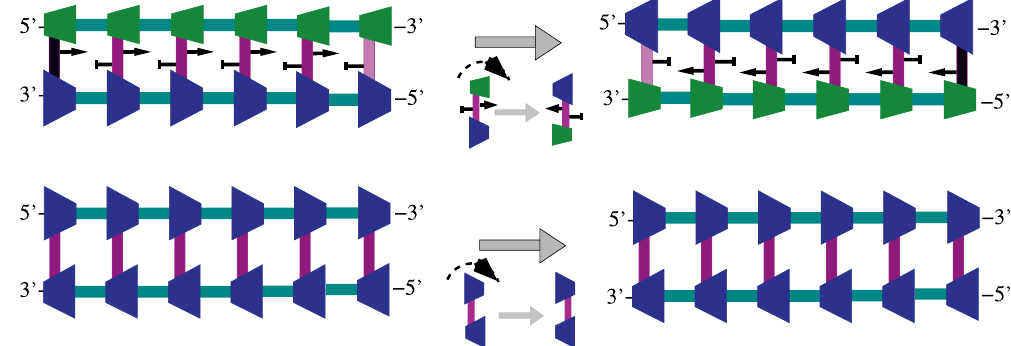
Figure 4. Illustration of the importance of heteromolecular base-pairing or base-pairing between different types of nucleotides. Incorporation of sequence-dependent asymmetric cooperativity requires the base-pair in anti-parallel DNA strands to be left-right asymmetric. On the top left and top right strands, base-pairs between different types of nucleotides, colored green and blue, are left-right asymmetric. Rotating the base-pair results in a directional structure with the blue and green nucleotides exchanged between the two strands, as shown below the arrow in the top center. Thus heteromolecular base-pairs can differentiate between their left and right, are directional, and hence can instantiate asymmetric cooperativity. Rotating the base-pair results in flipping of catalytic and inhibitory arrows associated with the base-pair and thus will impact the unzipping kinetics of the strand. It is easier to unzip the top-left strand from its right end, whereas, for the top-right strand, unzipping from its left end is kinetically favorable. This favorability is illustrated with the color of the hydrogen bonds, which represent the height of the kinetic barrier separating bonded and unbonded configurations, higher the barrier, darker the color. On the other hand, as the bottom left and bottom right strands illustrate, if the two nucleotides of a base-pair are of the same type, both colored in blue, Rotating the base-pair results in a non-directional structure, as shown below the bottom center arrow. Thus, homomolecular base-pairs cannot distinguish between left and right and hence cannot instantiate asymmetric cooperativity. Hence no catalytic or inhibitory arrows are shown in the bottom strands. Unzipping kinetics of the two bottom strands are the same due to their left-right